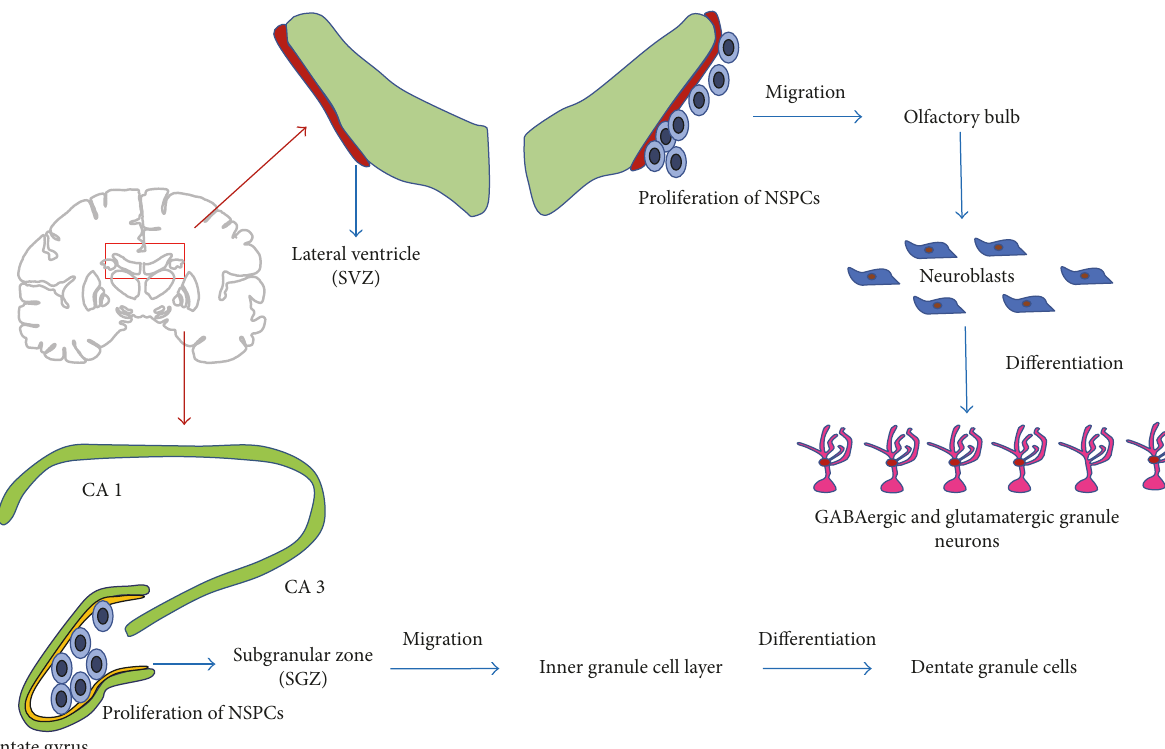
Figure 1: This fi gure demonstrates neurogenesis of endogenous neural stem cells. (1) Neurogenesis and proliferation occur in the SVZ and SGZ on the lateral ventricle and hippocampus, respectively. (2) NSPC migration occurs through the rostral migratory stream to the olfactory bulb, where neuroblasts migrate as interneurons through speci fi c cell layers. From the SGZ, NSPCs migrate to the inner granule cell layer. (3) Di ff erentiation occurs once neuroblasts reach glomeruli within the olfactory bulb or the inner granule cell layer. The majority of SVZ-derived neuroblasts become GABAergic granule neurons. After complete di ff erentiation and maturation of neuroblasts from the SGZ, new neurons possess GABAergic and glutamatergic